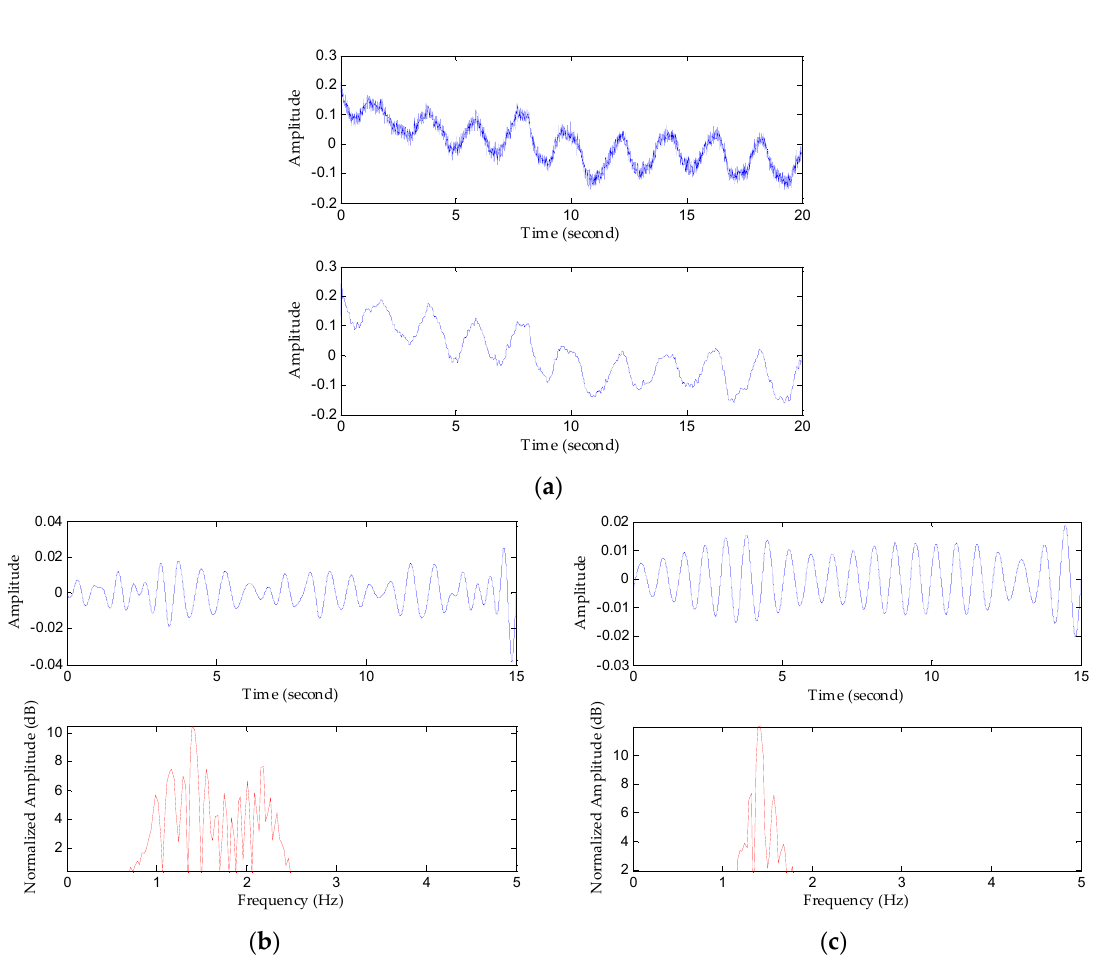
Figure 14. Comparison of results using the FIR filter and the proposed method to recover heartbeat waveforms 5 m away from the detector. ( a ) Original signal waveform and the denoised waveform; ( b ) heartbeat signal waveform extracted using the FIR filter and its spectrum; ( c ) heartbeat waveform extracted using the proposed method and its spectrum.